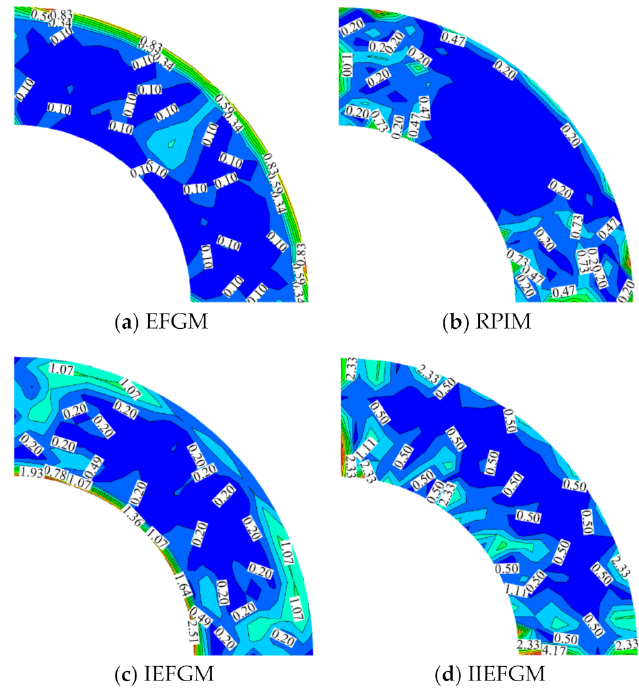
Figure 10. Contour plots of the relative error for the Von Mises